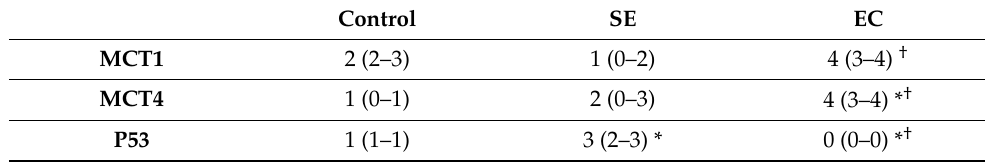
Table 2. Monocarboxylate transporters 1, 4, and p53 immunoreactivity in control and TGCTs.